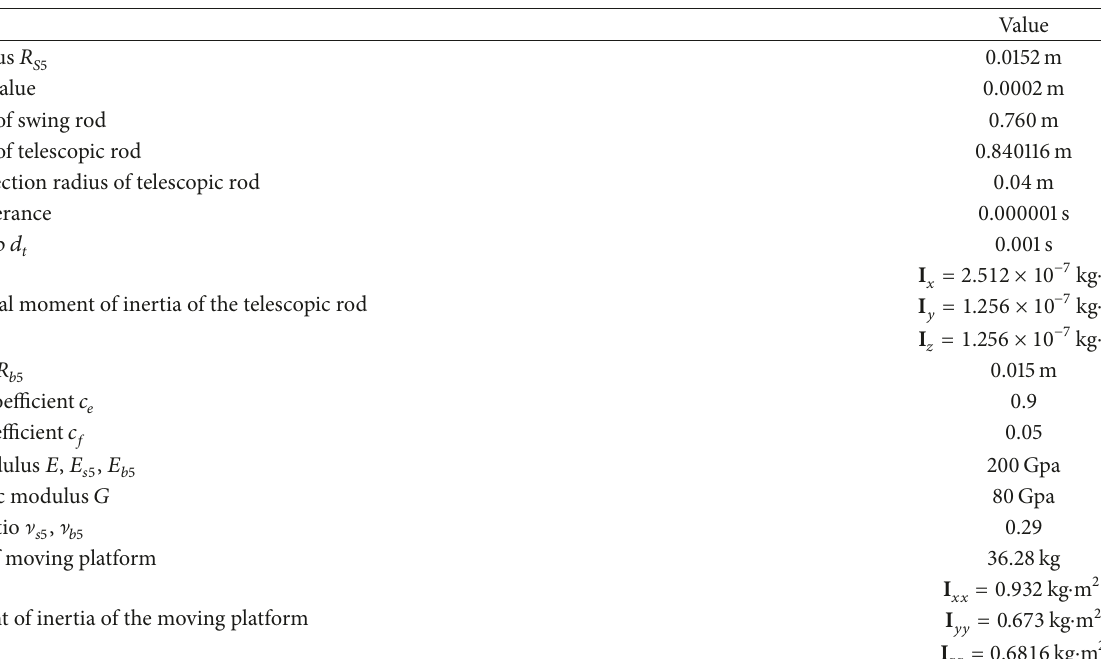
Table 2: The parameters of 4-UPS-RPS parallel